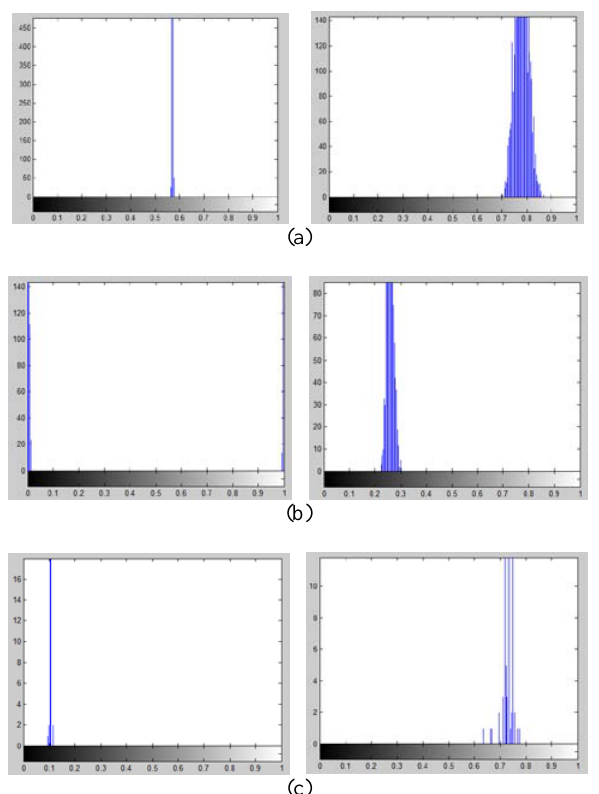
Figure 3. Histograms from images depicting (a) red, (b) blue and (c) yellow road signs for the Hue (left) and the Saturation (right)